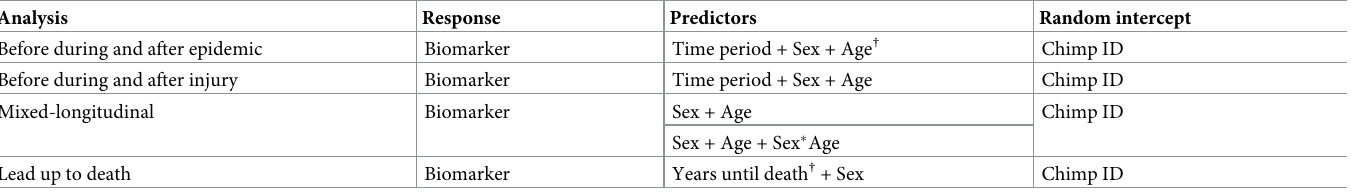
Table 1. Structure of linear mixed models of OS biomarkers’ response to infection and age.